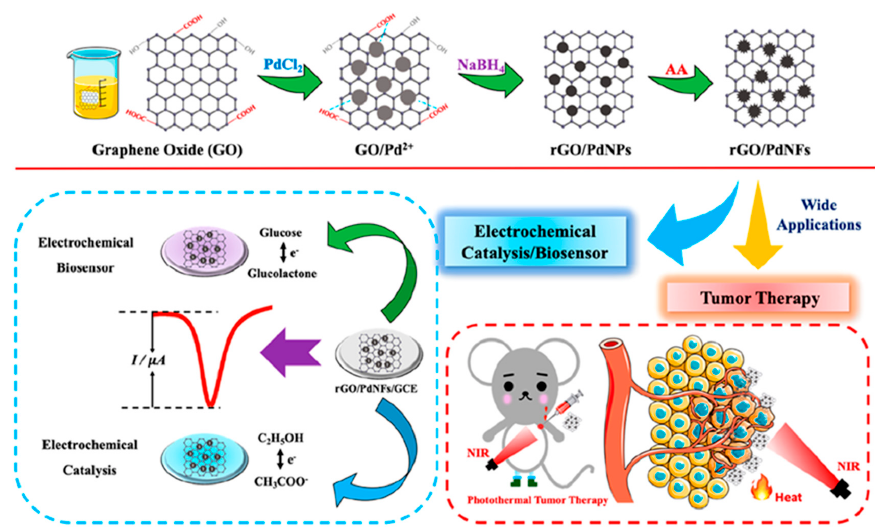
Figure 8. Schematic illustration of the synthetic route of rGO / PdNFs nanohybrids (top) and applications in non-enzymatic glucose sensing, electrochemical catalysis of ethanol, and photothermal tumor therapy in vivo (bottom). Reproduced from [107] with permission.